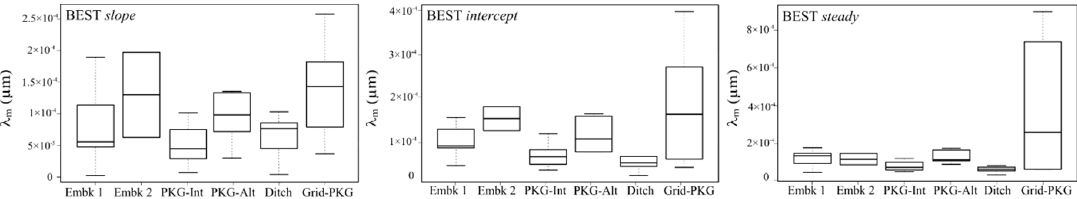
Figure 6. Average characteristic size of hydraulically activated pores, λ m , estimates by the three BEST methods. BEST methods.